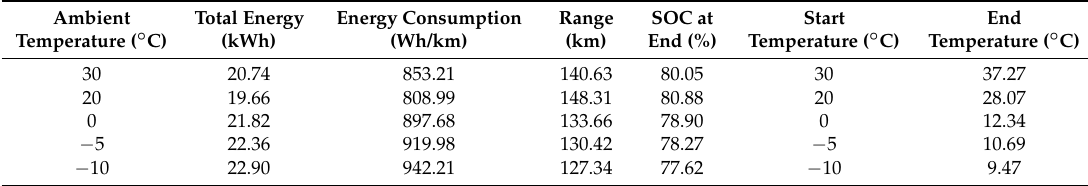
ambient Table 5. Energy consumption of an electric bus with a heat pump depending on changes in ambient temperature.